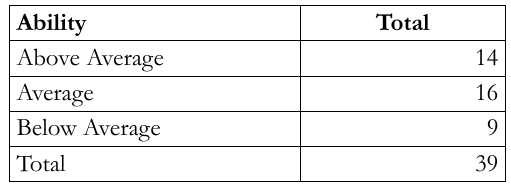
Table 1. Details of students’